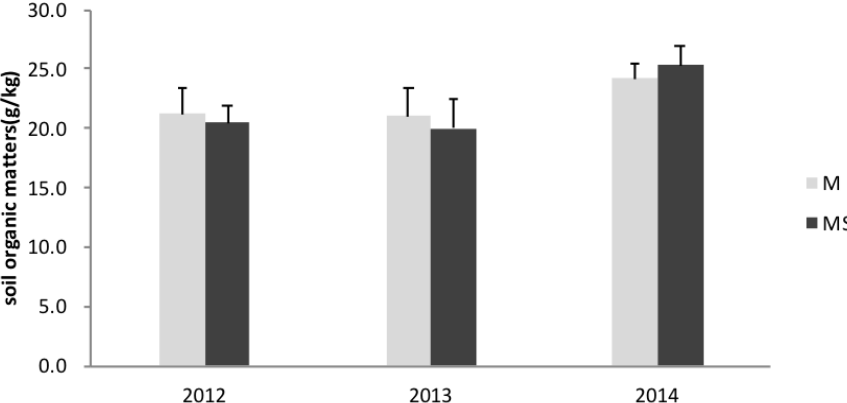
Figure 2. Soil organic matter change of two cropping systems. Values are means ± standard deviation. M is maize monocropping system, and MS is for maize–soybean intercropping system.